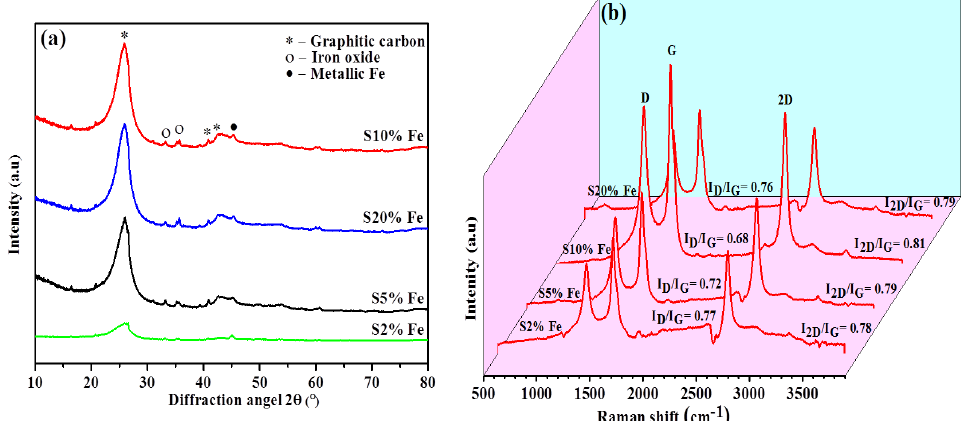
Figure 3. ( a ) X-ray diffraction patterns and ( b ) Raman spectra of different Fe-catalyst-loadings graphitized composite samples. Table 2. Structural properties of composite materials with different Fe-loadings fabricated via mi- crowave-assisted catalytic graphitization.